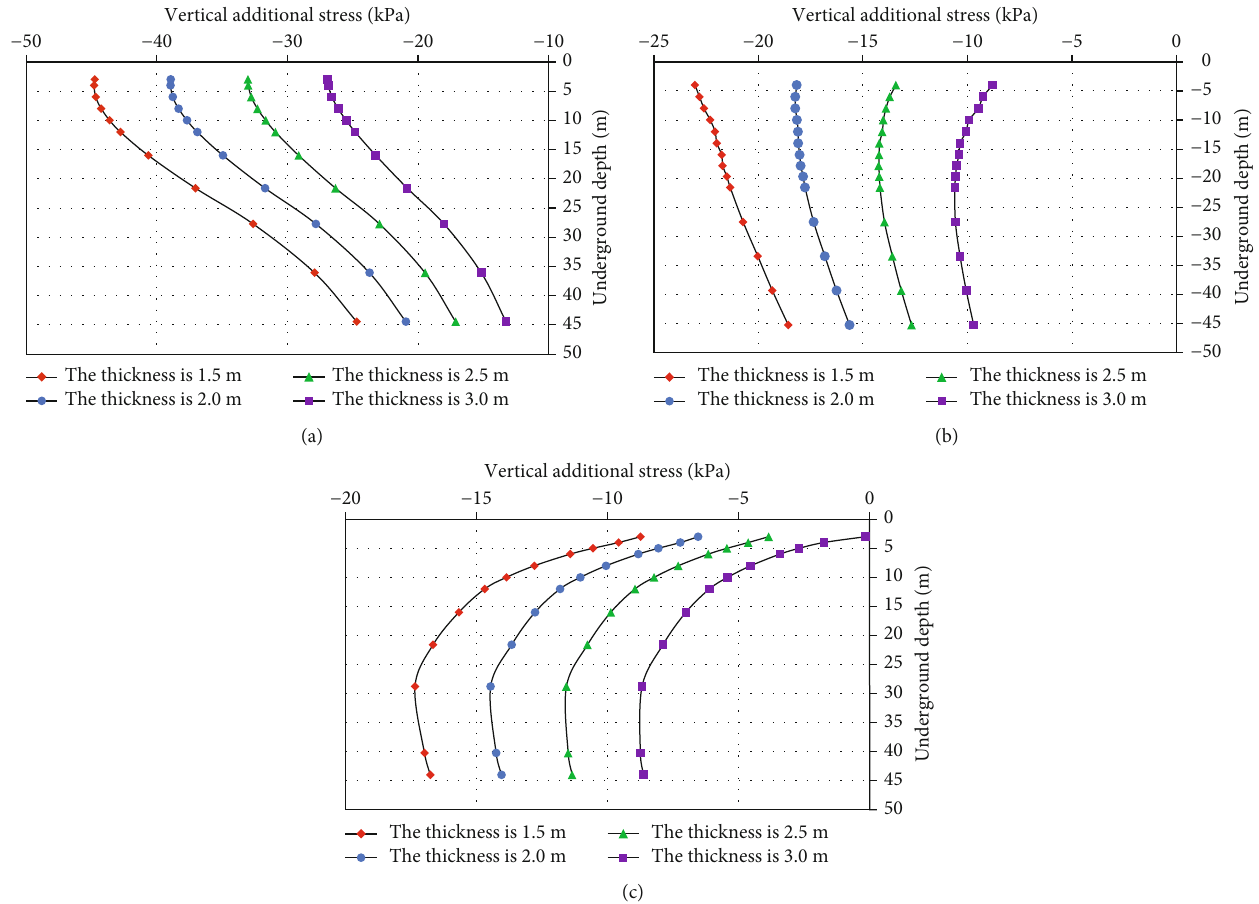
Figure 12: The vertical additional stress-underground depth curves with variable thickness of replacement under (a) embankment center, (b) embankment shoulder, and (c) slope toe.